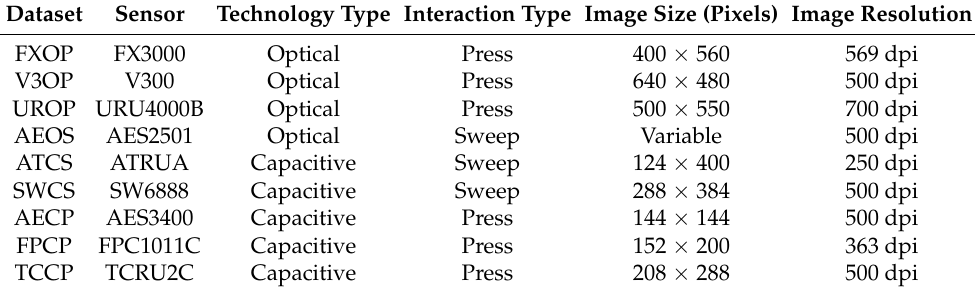
Figure 6. Example fingerprints of the same finger captured by 3 optical sensors from MOLF database. Table 1. Detail of FingerPass datasets [12]. The first two characters in the name of each dataset indicate the sensor type, whereas the last two characters represent the technology type (O-optical, C-capacitive) and the interaction type (P-press, S-sweep),